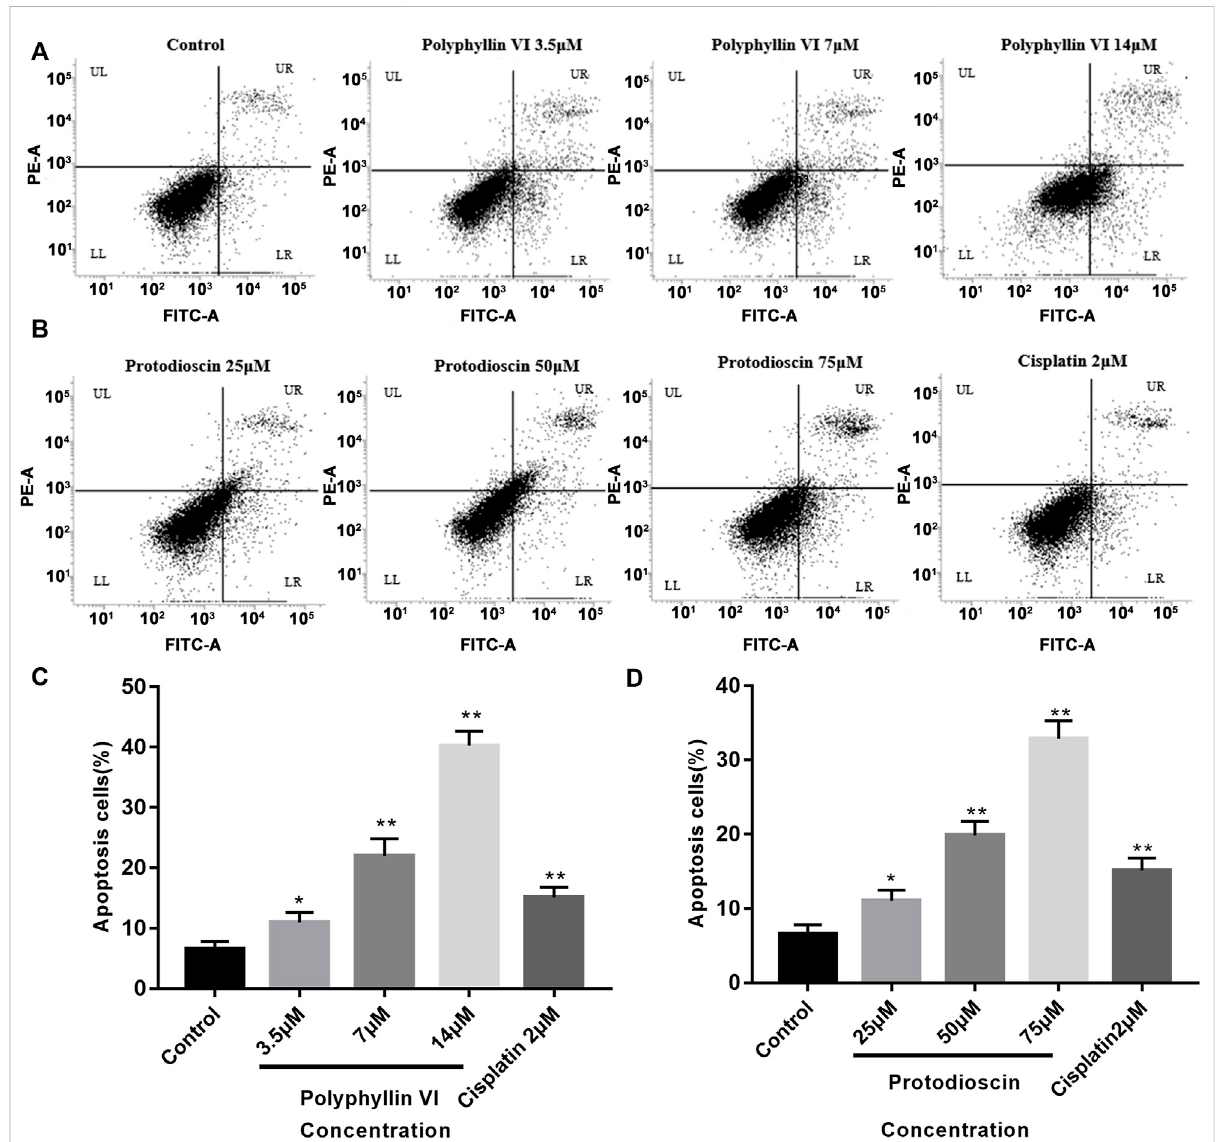
FIGURE 8 Polyphyllin VI and Protodioscin induce apoptosis of A549 cells. (A,B) Apoptosis was detected by annexin V/PI staining. UL represents necrotic cells, LL represents normal cells, UR represents late apoptotic cells, and LR represents early apoptotic cells. (C,D) The data show that treatment of A549 cells with Polyphyllin VI, Protodioscin and Cisplatin for 48 h signi fi cantly induced apoptosis (* p < 0.05, ** p < 0.01, compared with the control